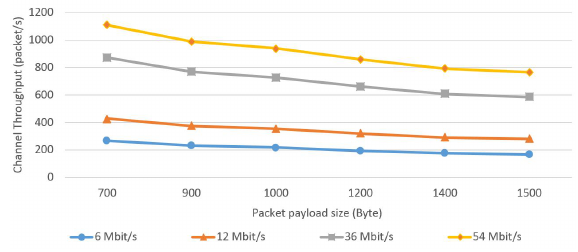
Figure 10: Channel throughput of each central (Scenario 2.)